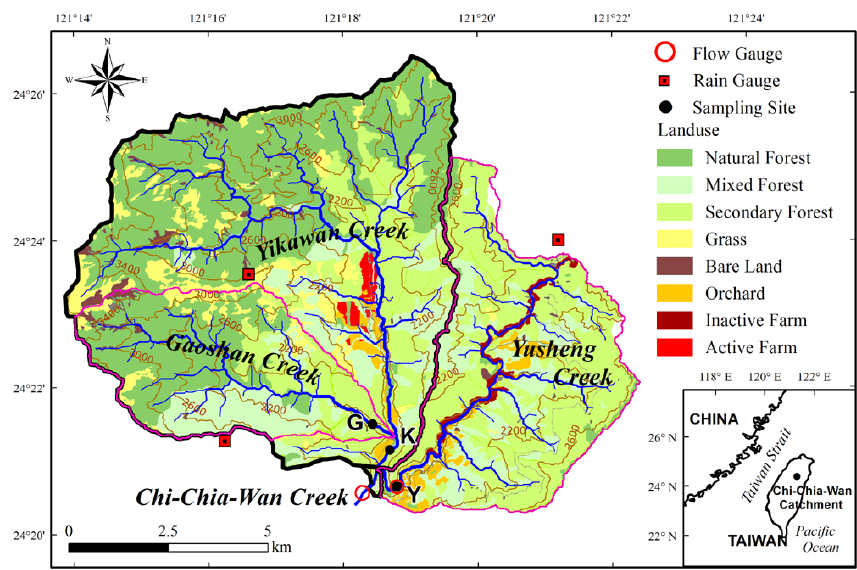
Fig. 1. The landscape of the study watershed, including sampling sites, rainfall gauges, discharge gauges and land use patterns. The study watershed was divided into three sub-catchments representing pristine (water samples taken at Sta. G), moderately cultivated (Sta. K), and intensively cultivated watersheds (Sta. Y). Table 1. Basic landscape characteristics and land use patterns in the pristine, moderately cultivated, and intensively cultivated watersheds. Landscape characteristics Creek name Sta. ID Drainage area Slope Elevation Max. flow length (km 2 ) (deg.) (m) (km) G 21.05 74.4